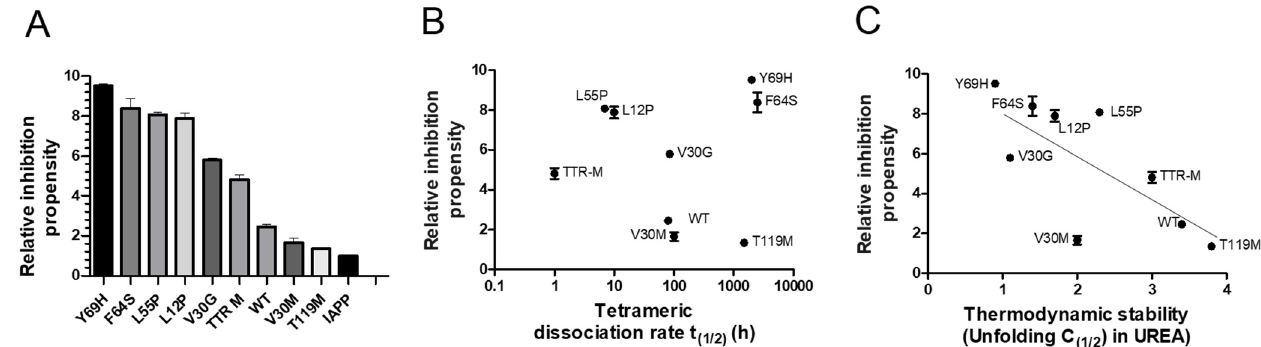
Figure 3. ThT analysis of the relative islet amyloid polypeptide (IAPP)-amyloid inhibiting propensity exerted by TTR-wt, L12P, V30M, V30G, L55P, F64S, Y69H, T119M, and the monomeric variant TTR-M. The lag-phase of the TTR-wt versus control was set to 1.0, and the effect from all other TTR-variants were normalized accordingly ( A ). The relative inhibitory effects of the specific TTR-variants are plotted as a function of kinetic stability represented by the dissociation-rate of the tetramer ( B ) and thermodynamic stability ( C ). An inverse correlation between the inhibitory effect and thermodynamic stability is shown (r 2 = 0.53 and p -value <0.0001).